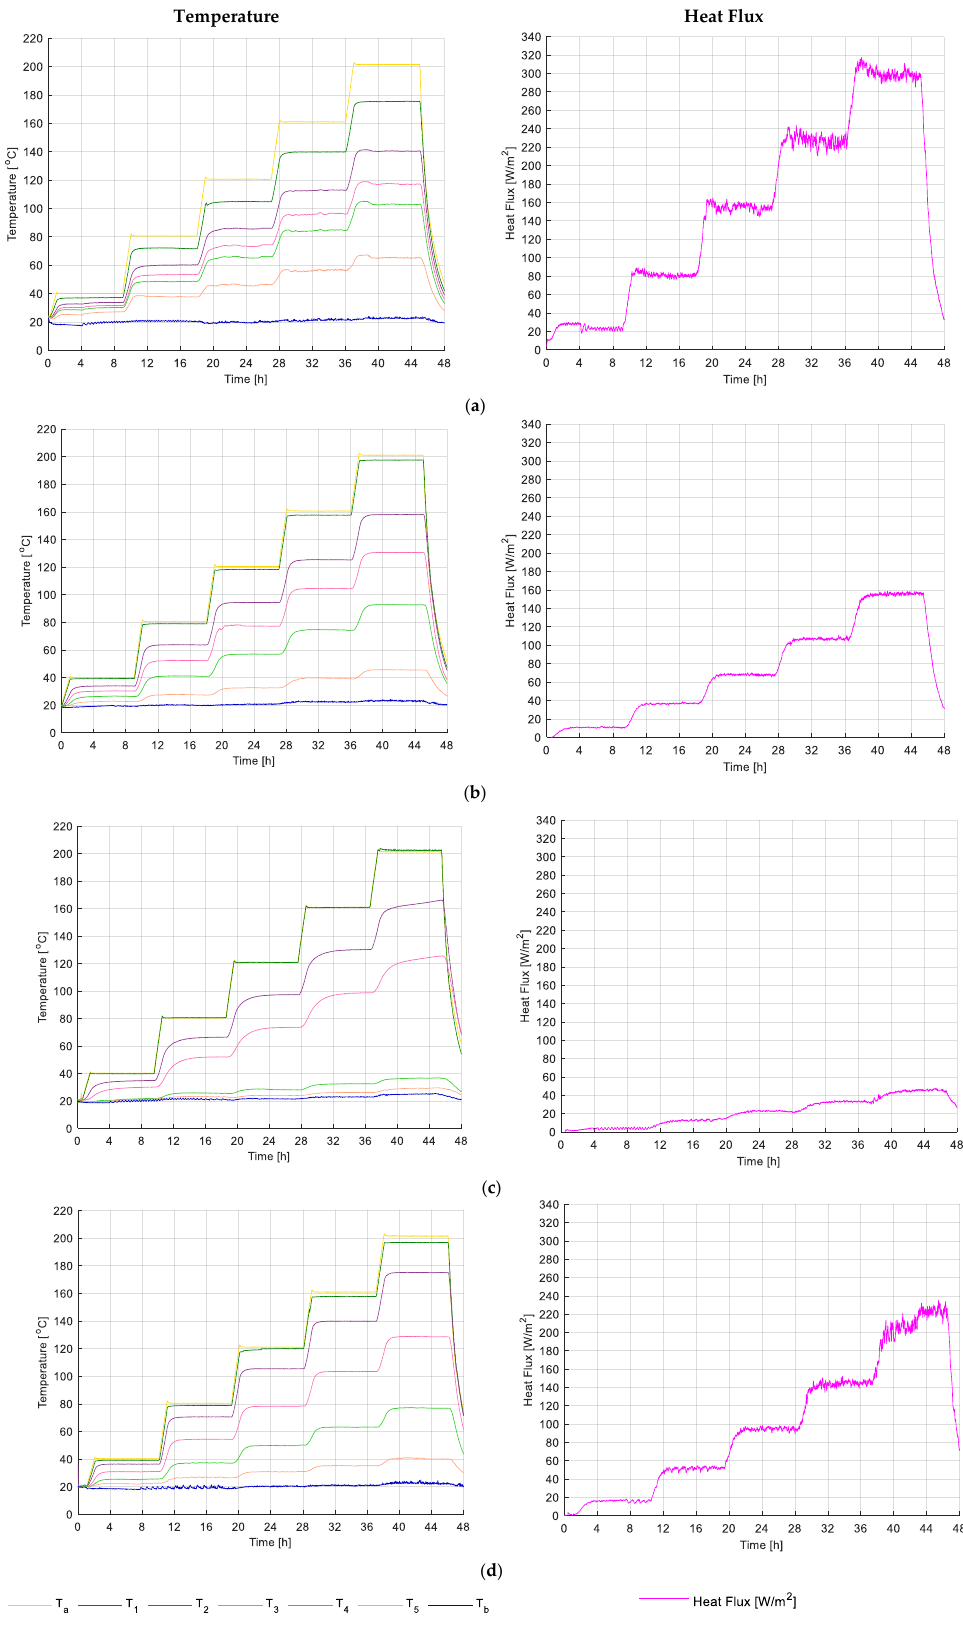
Figure 8. Examples of temperature and heat flux recorded during the test: ( a ) BAL panel; ( b ) PET panel; ( c ) PUR panel; ( d ) MW panel.